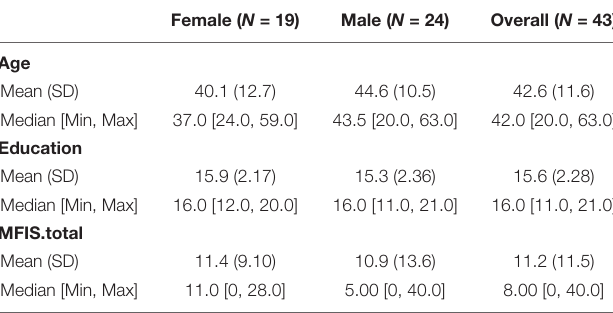
TABLE 1 | The demographics of the